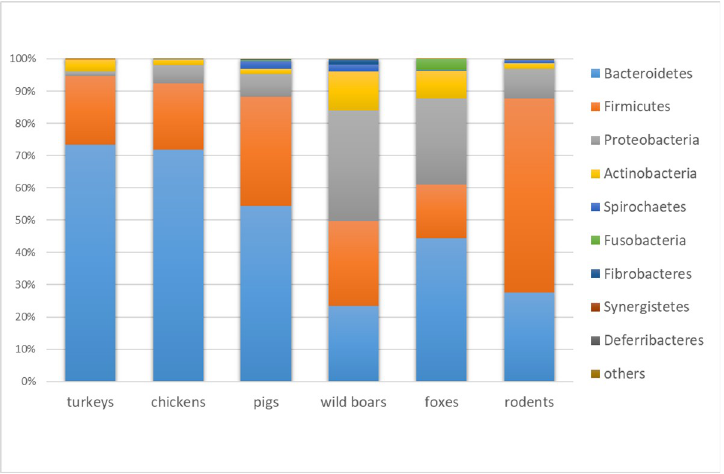
Fig 5. Bacterial composition at phylum level by animal source. Stacked column chart with relative abundances of the most abundant bacterial phyla based on relative abundances.